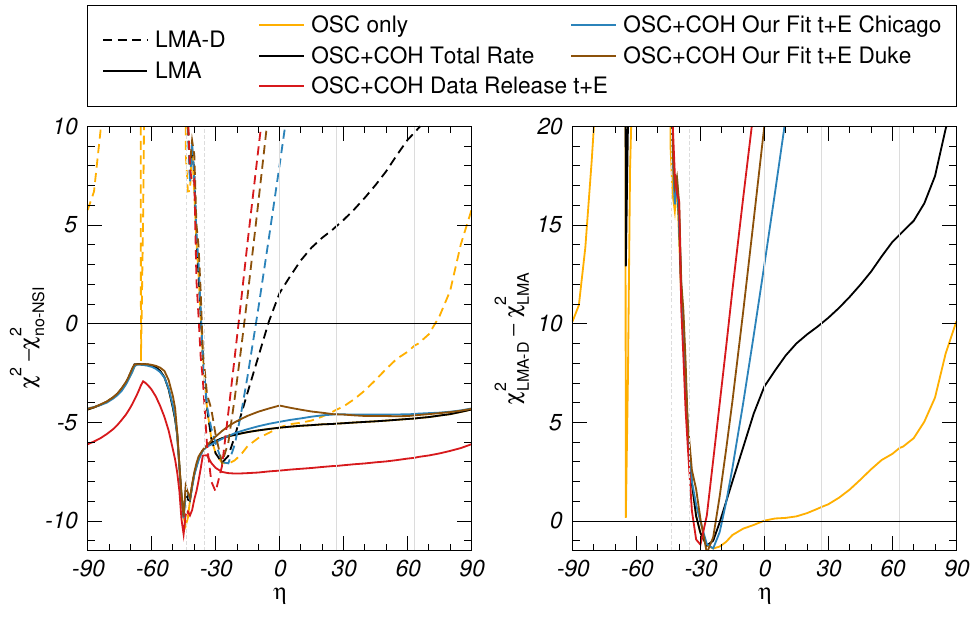
Figure 8 . Left: (cid:31) 2 analysis of di(cid:11)erent data combinations (as labeled in the (cid:12)gure) as a function of the NSI quark coupling parameter (cid:17) . Right: (cid:31) 2 for